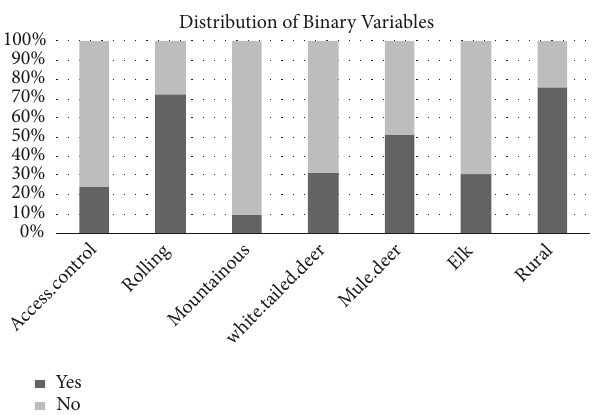
Figure 1: The distribution of binary variables in the defined